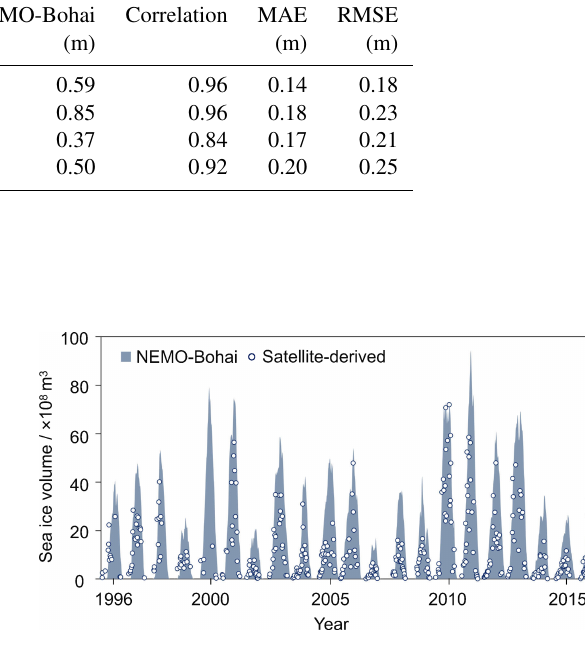
Figure 11. Comparison of daily sea ice volume between satellite- derived data (circles) and NEMO-Bohai simulations (grey bars) from 1996 to